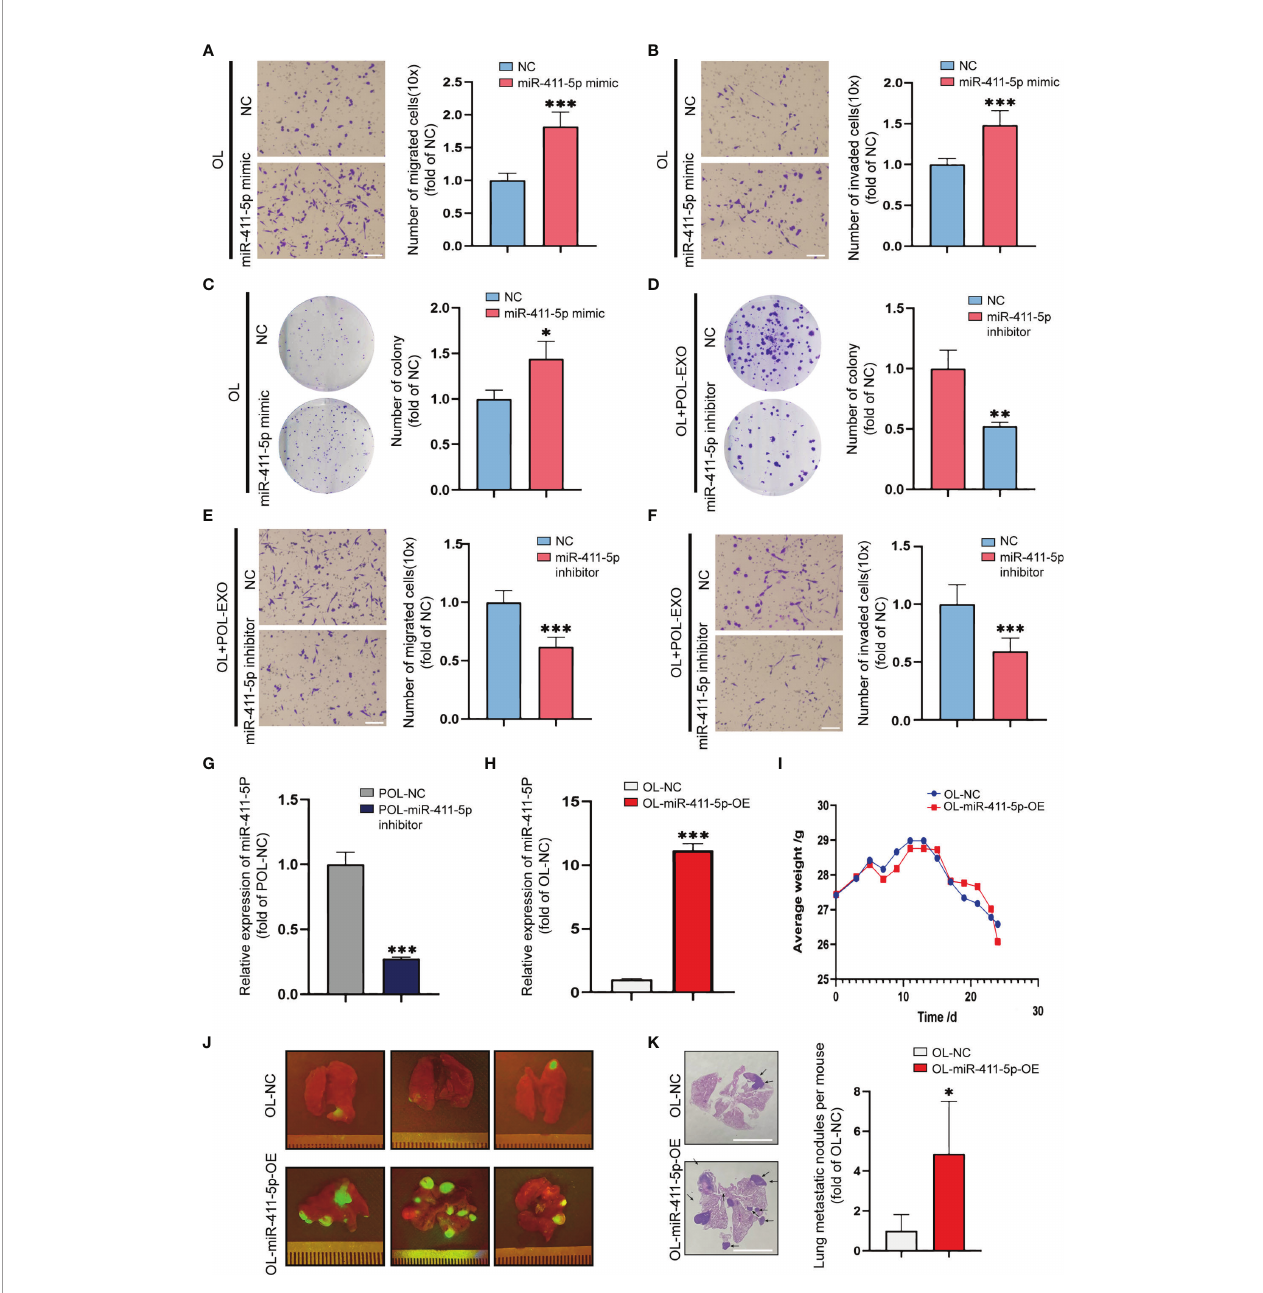
FIGURE 4 | Overexpression of miR-411-5p signi fi cantly enhanced the metastatic colonization ability of OL in vitro and in vivo . Transwell assays without Matrigel or with Matrigel were used to determine the effect of miR-411-5p mimics on the migration (A) , bar = 60 m m, ***p<0.001) and invasion (B) , bar = 60 m m, ***p<0.001) of OL cells, respectively. The effect of miR-411-5p mimics on the colony formation ability of OL cells was measured using colony formation assays (C) , *p<0.05). The effect of exosomes (40 m g) secreted by POL-NC and POL-miR-411-5p inhibitor-treated cells on the colony ability of OL cells was measured using colony formation assays (D) , **p<0.01). Transwell assays without Matrigel or with Matrigel were used to determine the effect of exosomes secreted by POL-NC and POL-miR-411-5p inhibitor-treated cells on migration (E) , bar = 60 m m, ***p<0.001) and invasion (F) , bar = 60 m m, ***p<0.001), respectively. The expression of miR-411-5p in POL-NC and POL-miR-411-5p inhibitor was measured by qRT-PCR (G) , ***p<0.001). The expression of miR-411-5p in OL-NC and OL-miR-411-5p-OE was measured by qRT-PCR (H) , ***p<0.001). (I) The weight curves of mice injected with OL-NC and OL-miR-411-5p-OE Cells. (J) Visualization analysis of the effect of miR-411-5p overexpression on